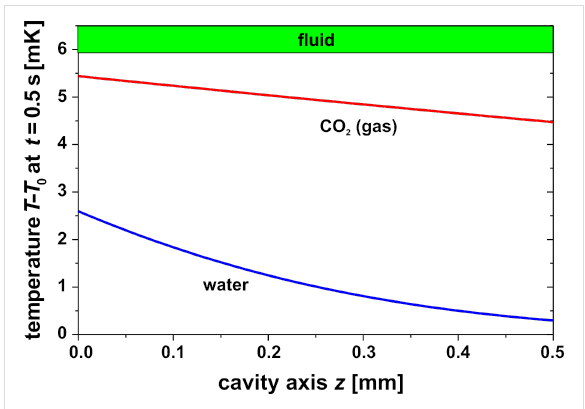
Figure 8: Temperature distribution along the cavity axis z 0.5 s after the onset of irradiation for a water-filled and a CO 2 -filled cavity with an IR power density at the outer window surface of 10 W/m 2 . In the case of gas, a thin IR absorber film is assumed on the inner glass surface where all the IR energy is absorbed.